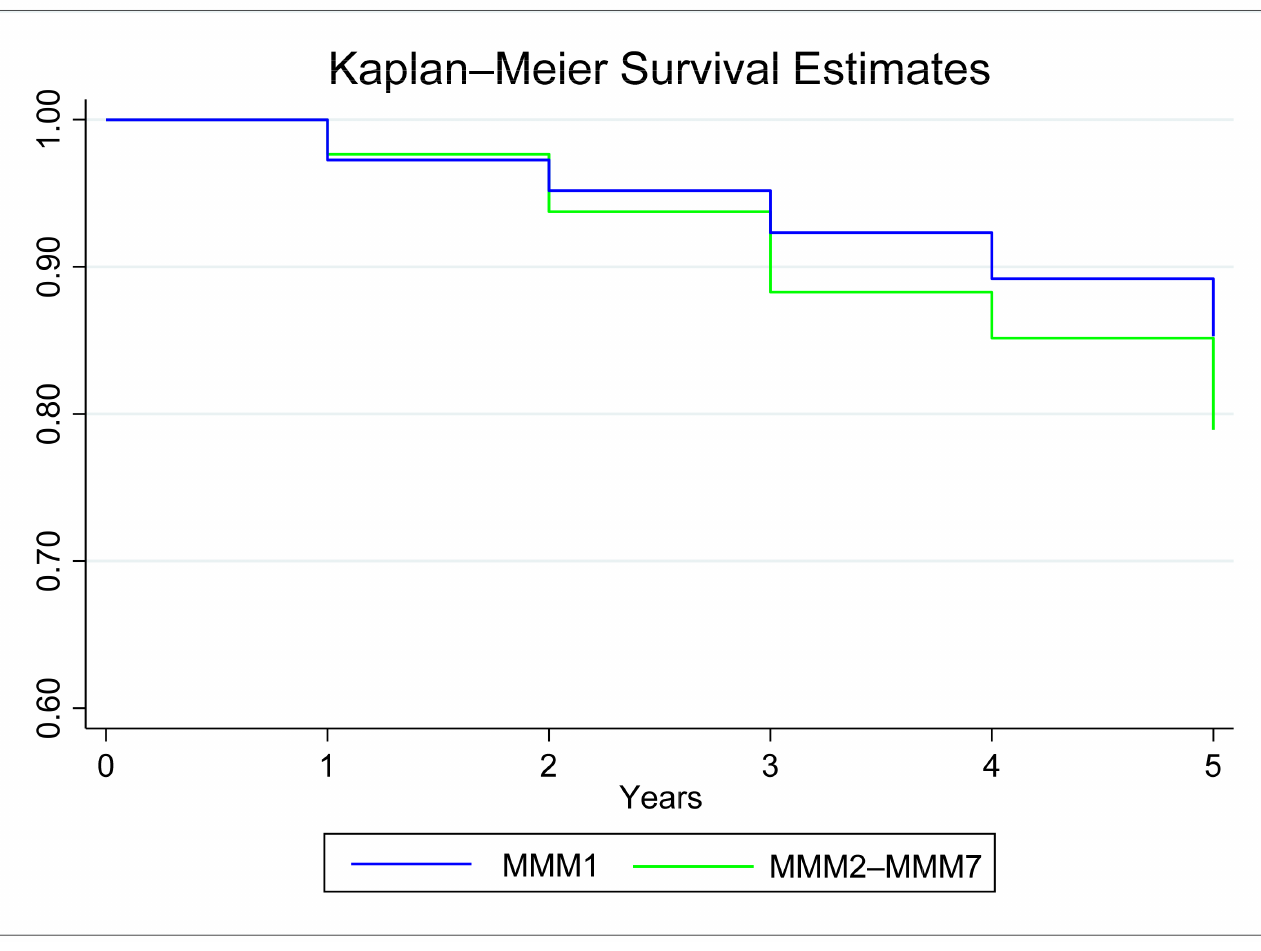
Figure 1. Kaplan-Meier Survival Estimates for staying practicing in MMM1 and MMM2–MMM7, 2014 to 2019. Seven ophthalmologists were notified to be deceased up to 2018, the last year that AHPRA provided registration status. There were 20 ophthalmologists who relocated their primary place of practice to a different MMM category and 82 ophthalmologists who had a registration status of failed to renew, surrendered or deceased from 2014 to 2018. The competing-risks regression found the sub-hazard for moving MMM among ophthalmolo- gists with a primary place of practice in MMM1 in 2014 was 24% (SHR 0.24, 95% CI 0.10, 0.59, p = 0.002) that of ophthalmologists with a primary place of practice in MMM2–MMM7. However, there was no significant difference in leaving MMM due to failure to renew, surrendered or deceased (SHR 1.08, 95% CI 0.58, 2.03, p = 0.80). Figure 2 presents the cu- mulative incidence plots of moving MMM or leaving MMM for another reason (e.g., failed to renew, surrendered, deceased) between 2014 and 2018, for ophthalmologists in MMM1 compared with